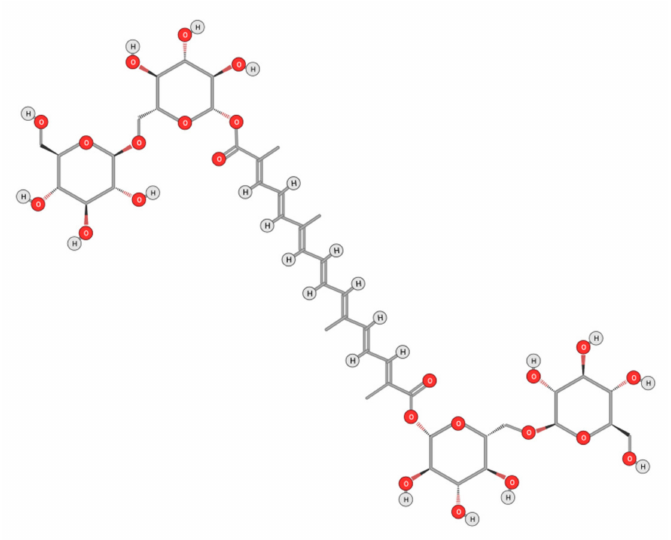
Figure 14. Chemical structure of